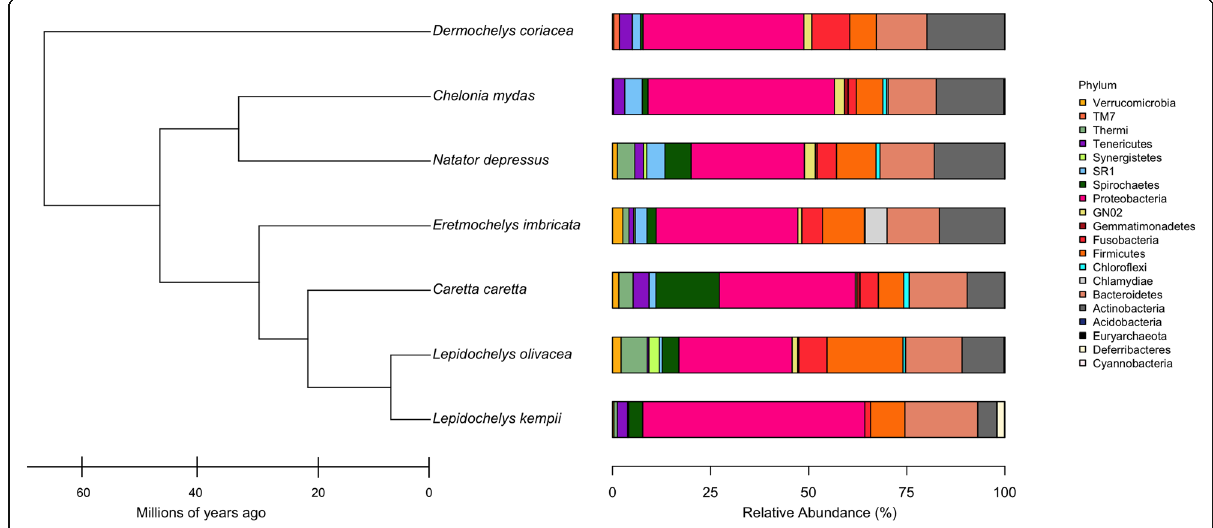
Fig. 1 Relative abundance of bacterial phyla in each sea turtle species together with their phylogenetic